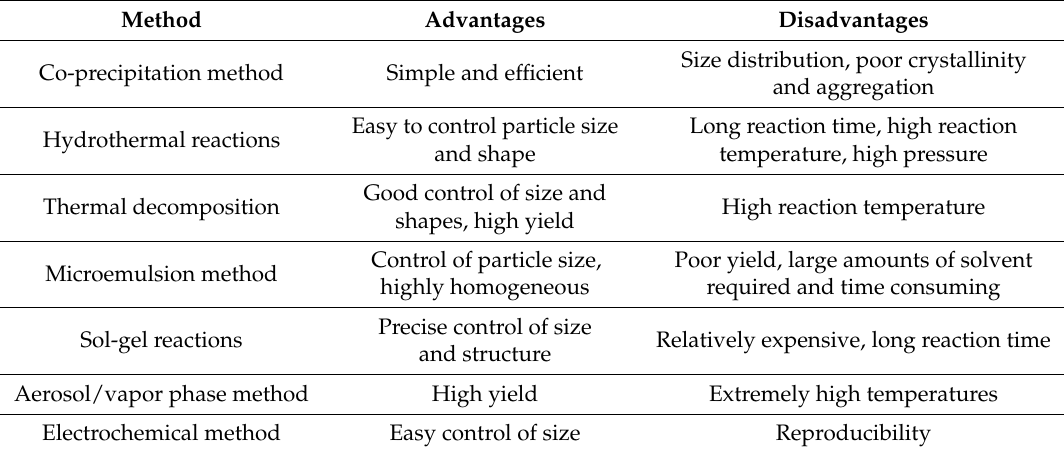
Table 1. Principal preparation methods of iron oxide nanoparticles